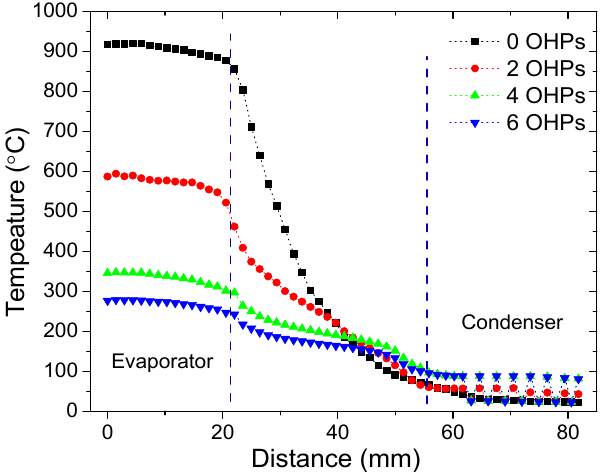
Figure 10. Temperature on the grinding wheel along the axial direction (10 7 W/m 2 ).